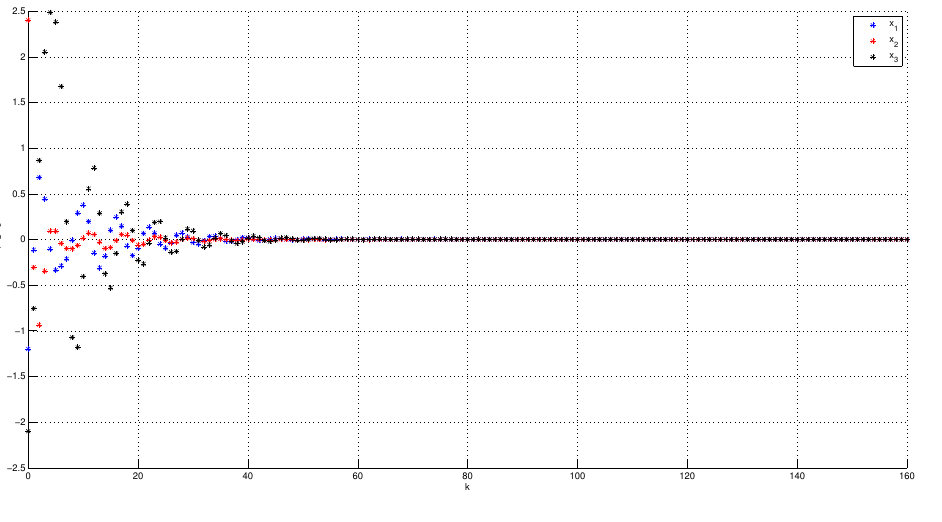
Figure 2. The stability of the trivial solution of system (28) with x 1 ( 0 ) = − 1.2, x 2 ( 0 ) = 2.4, x 3 ( 0 ) = −